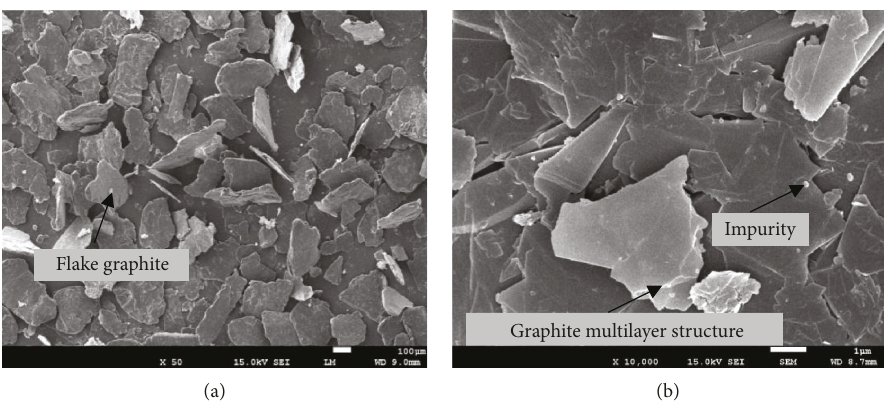
Figure 1: Graphite morphology. (a) Overall morphology at 50 times. (b) Local morphology at 5000 times.